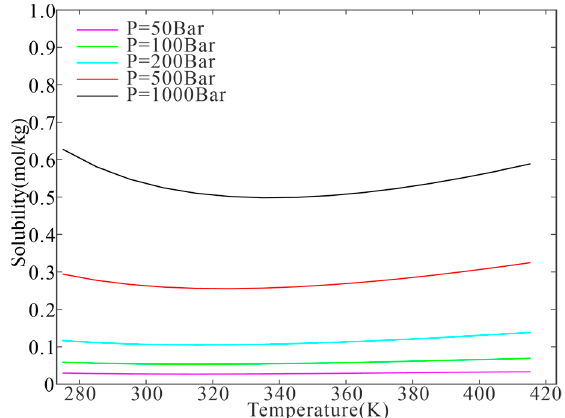
Figure 4. Isobaric minimum solubilities of H 2 in pure water.